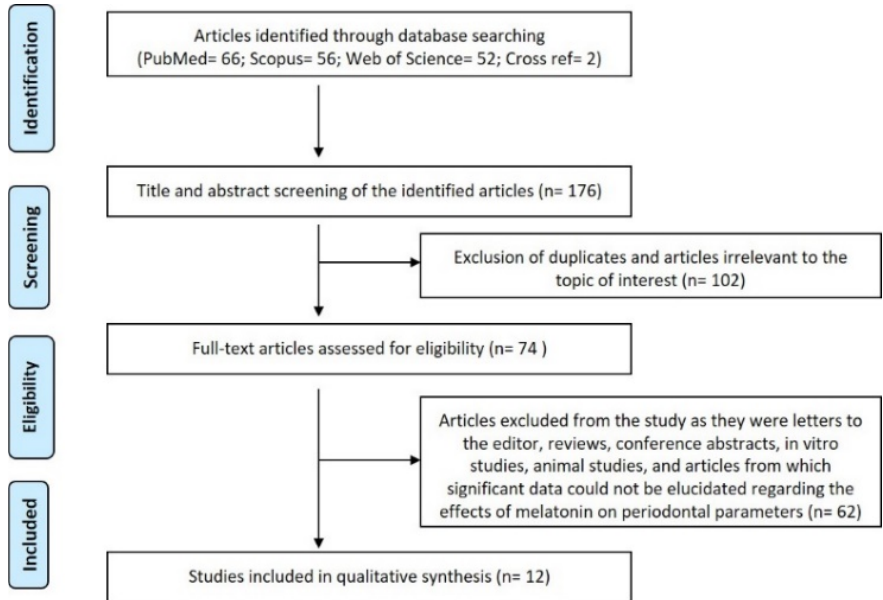
Figure 1. Summary of the search strategy employed in the systematic